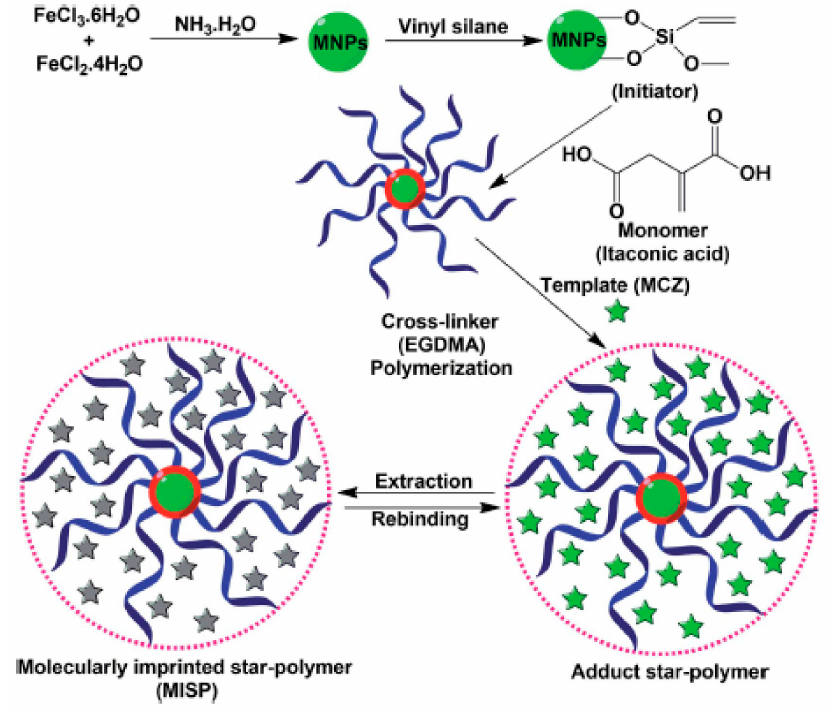
Figure 11. Different steps of fabrication of mancozeb-imprinted star polymer. Reproduced with permission of RSC from